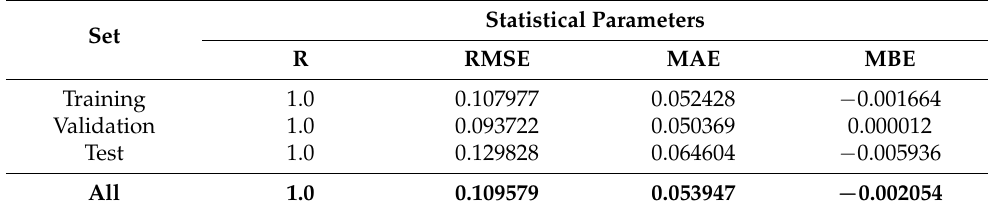
Table 2. Statistical parameters of ANN model for the training, validation, test, and all data.